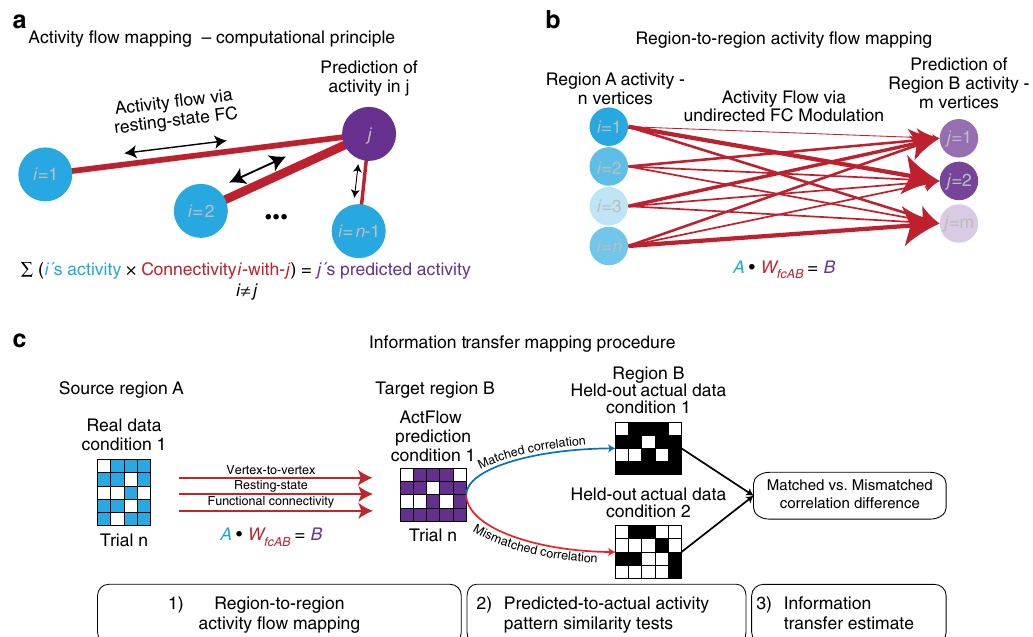
Fig. 1 Measuring information transfer through activity fl ow mapping and cognitive task information decoding. a Computational principle of activity fl ow mapping, as used by Cole et al. 14 . Adapted with permission from Cole et al. Activity in a held-out region is predicted by computing the linear weighted sum of all other regions ’ activity weighted by those regions ’ resting-state FC estimates with the held-out region (the held-out region ’ s activity is not included when computing the predicted activity of that region, thus avoiding a circular prediction). b Region-to-region activity fl ow mapping between vertices/ voxels of isolated regions ( “ many-to-many ” rather than “ all-to-one ” mapping of regions). Mathematically, we predict the activation pattern in Region B by computing the dot product of Region A ’ s activation pattern vector with the vertex-to-vertex resting-state FC matrix between Region A and B. c Information transfer mapping, which involves region-to-region activity fl ow mapping and representational similarity analysis (information decoding/classi fi cation) on held-out data. To test the transfer of task information from Region A to Region B, we compare the predicted activation pattern of Region B (mapped using Region A ’ s activation pattern) to the actual task activation pattern of Region B for all task conditions using a spatial Spearman ’ s rank correlation. For every prediction, spatial correlations to the task prototypes are computed and the information transfer estimate is measured by taking the difference of the correctly matched spatial correlation to the average of the incorrectly matched (mismatched) spatial correlations. Here, we depict the approach for